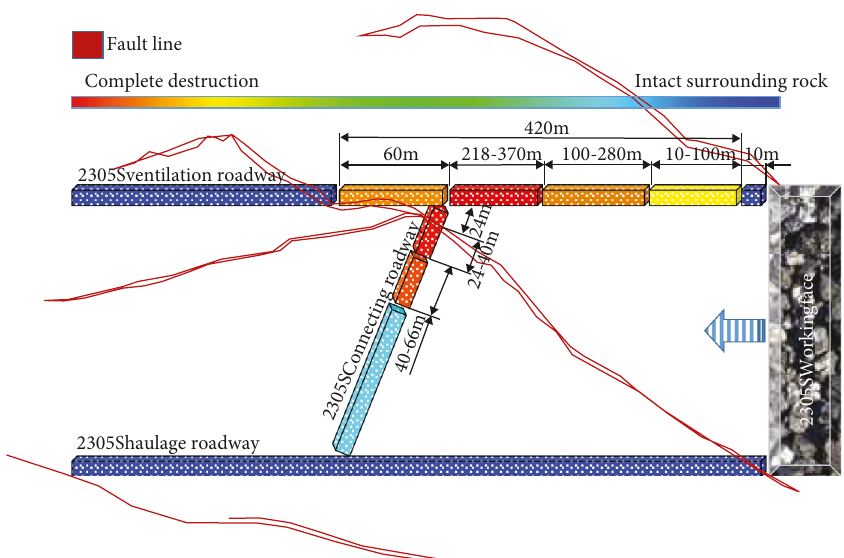
Figure 1: Schematic diagram of fault and impact damage degree of roadway in mining area (refer to Fan Shifu Prevention measures and methods of deep shaft rock burst in Xinjulong coal mine, Coal Mine Modernization, 2019 (4):